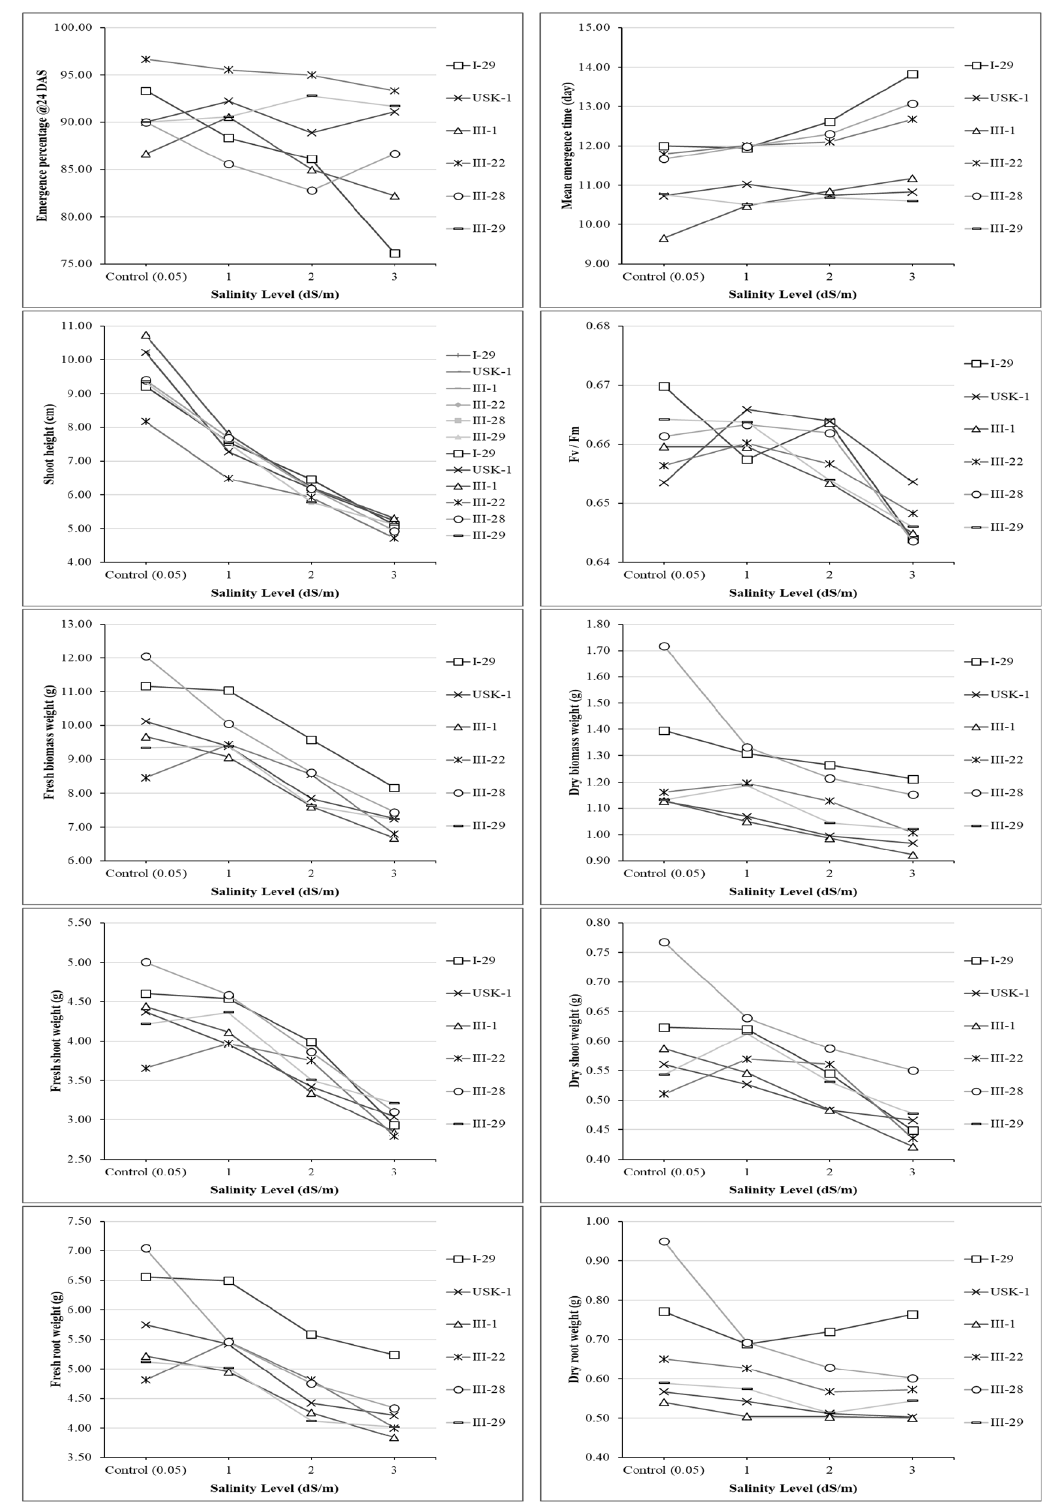
Figure 1. Comparison of faba bean genotypes under the main effect of salinity